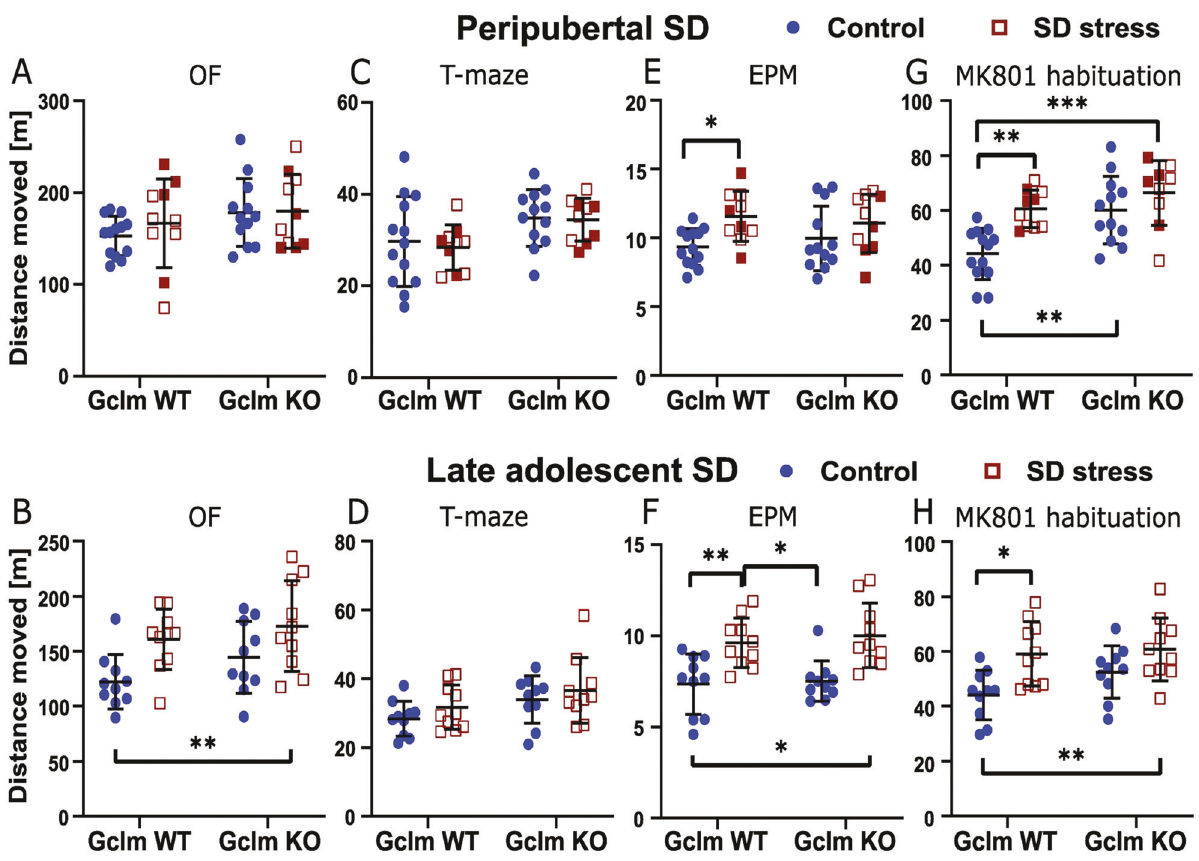
Fig. 2 Long-lasting effects of peripubertal and late adolescent social defeat (SD) stress on exploratory activity in novel environments in WT and Gclm-KO mice. A , B open fi eld (OF), C , D T-maze, E , F elevated-plus maze (EPM), and G , H arena used for the MK-801 test. Signi fi cant peripubertal SD effect in E and G ; signi fi cant late adolescent SD effect in B , F , and H ; signi fi cant genotype effect in G . Filled squares depict mice exposed to peripubertal SD that display strong reduction in social interaction. Control mice are non-stressed individuals. Data are presented with the mean and s.d. Post-hoc test: ** p < 0.01, ** p < 0.01, *** p <